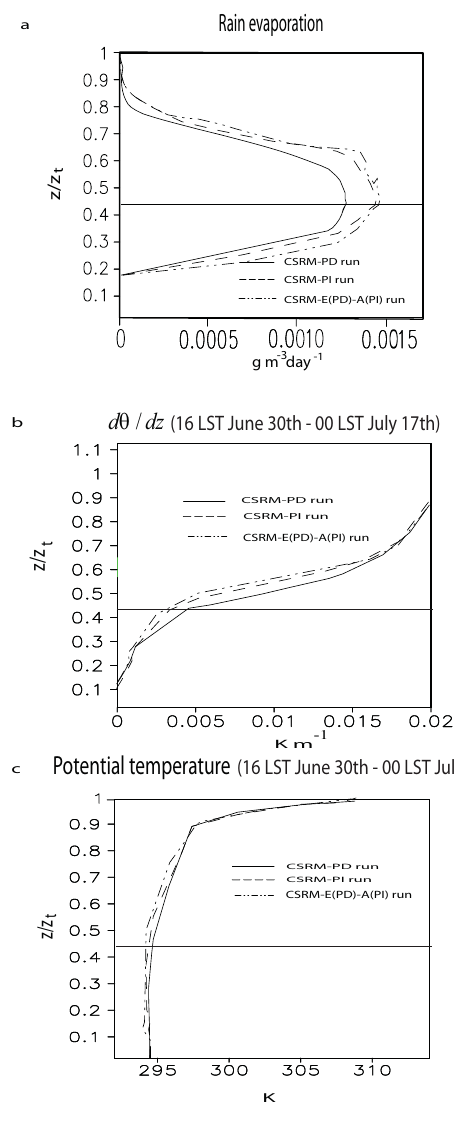
Fig. 12. Vertical distribution of time- and area-averaged (a) rain evaporation, (b) dθ (K m − 1 ) , and (c) θ (K) for the CSRM-PD run, dz the CSRM-PI run, and CSRM-E(PD)-A(PI) run. (a) is averaged over the entire simulation period while (b) and (c) are averaged over 16:00LST on 30 June–00:00LST on 17 July. The solid horizontal line in each figure is the average cloud-base height normalized with respect to cloud-top height ( z t )